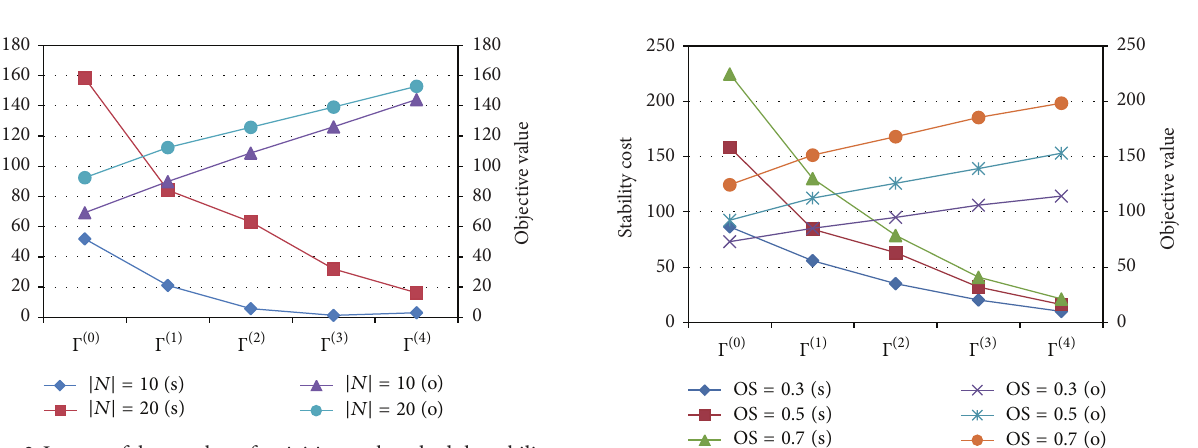
Figure2:Impactofthenumberofactivitiesontheschedulestability (OS = 0.5 , |𝑀| = 4 ). Figure 3: Impact of the order strength on the schedule stability ( |𝑁| = 20 , |𝑀| = 4 ).